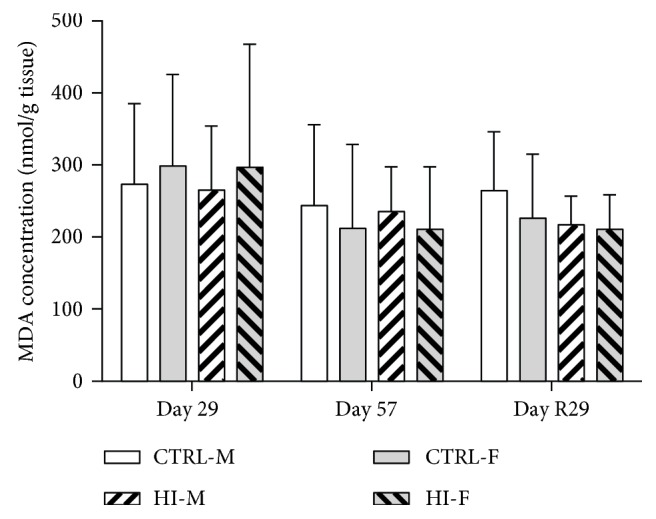
MDA concentration in brain tissue, mean + SD. CTRL-M: n = 7 − 10, HI-M: n = 5 − 7, CTRL-F: n = 8 − 9, and HI-F: n = 6 − 9. Statistical analysis showed no effect of HI-dosing or sex at any of the time points.